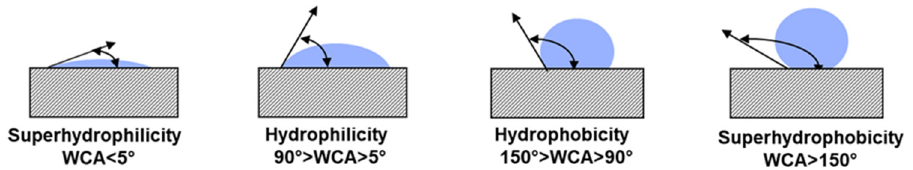
Figure 2. Wetting regimes, defined by the water contact angle (WCA) of a static drop on a solid, passive surface.